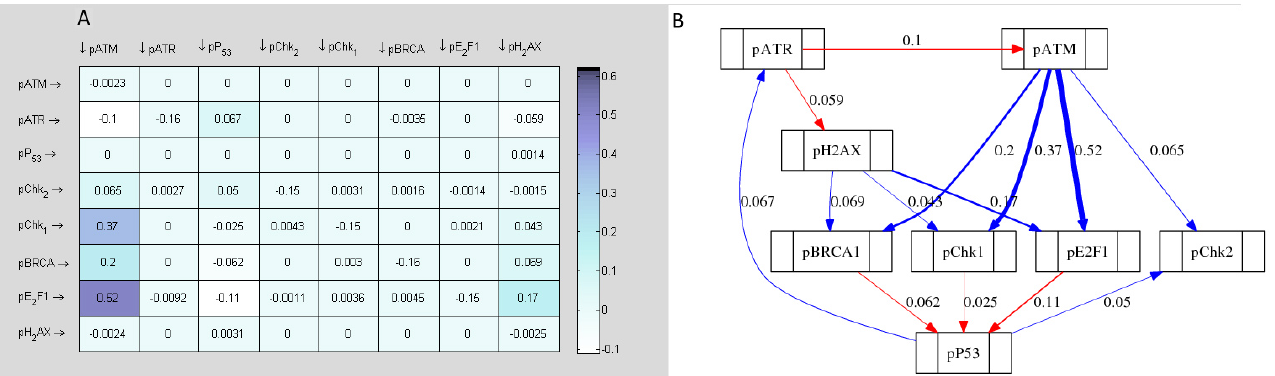
Figure 18. Constructed network model of time series data of the DDR pathway: (A) - inferred interaction matrix of 0 . 4 µ M DOX time series data (i.e. without ATM inhibition) using only data with timepoints 12-24hr; (B) - derived topological map (network of interactions) of 0 . 4 µ M DOX time series data (i.e. without ATM inhibition) using only data with timepoints